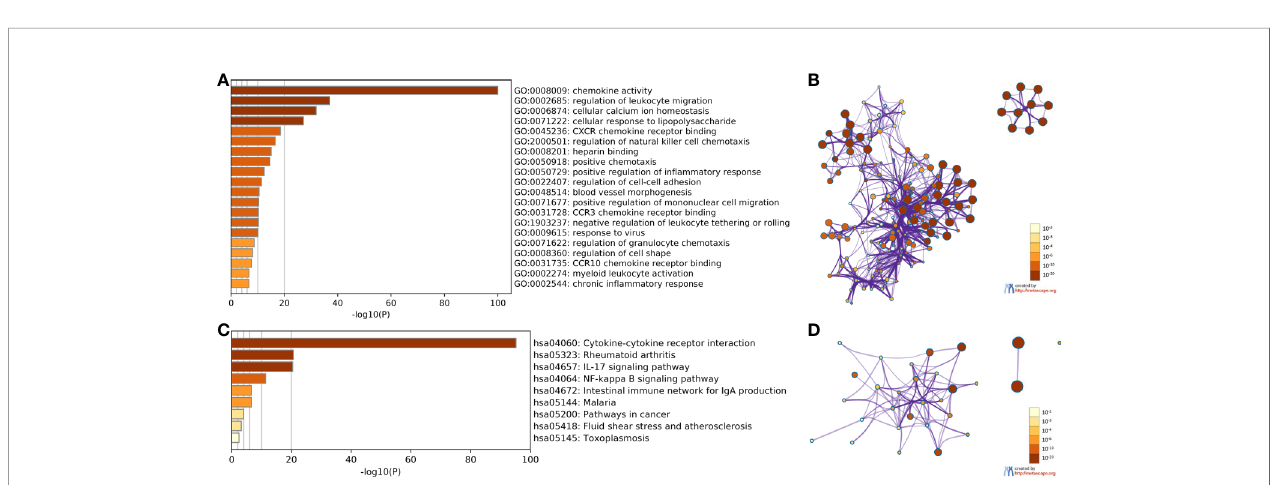
FIGURE 6 | The enrichment analysis of CXC chemokines and neighboring genes in HNSCC (Metascape). (A) Heatmap of Gene Ontology (GO) enriched analysis (B) Interaction Network of GO enriched analysis. (C) Heatmap of Kyoto Encyclopedia of Genes and Genomes (KEGG) enriched analysis. (D) Interaction Network of KEGG enriched terms. Note: color by p